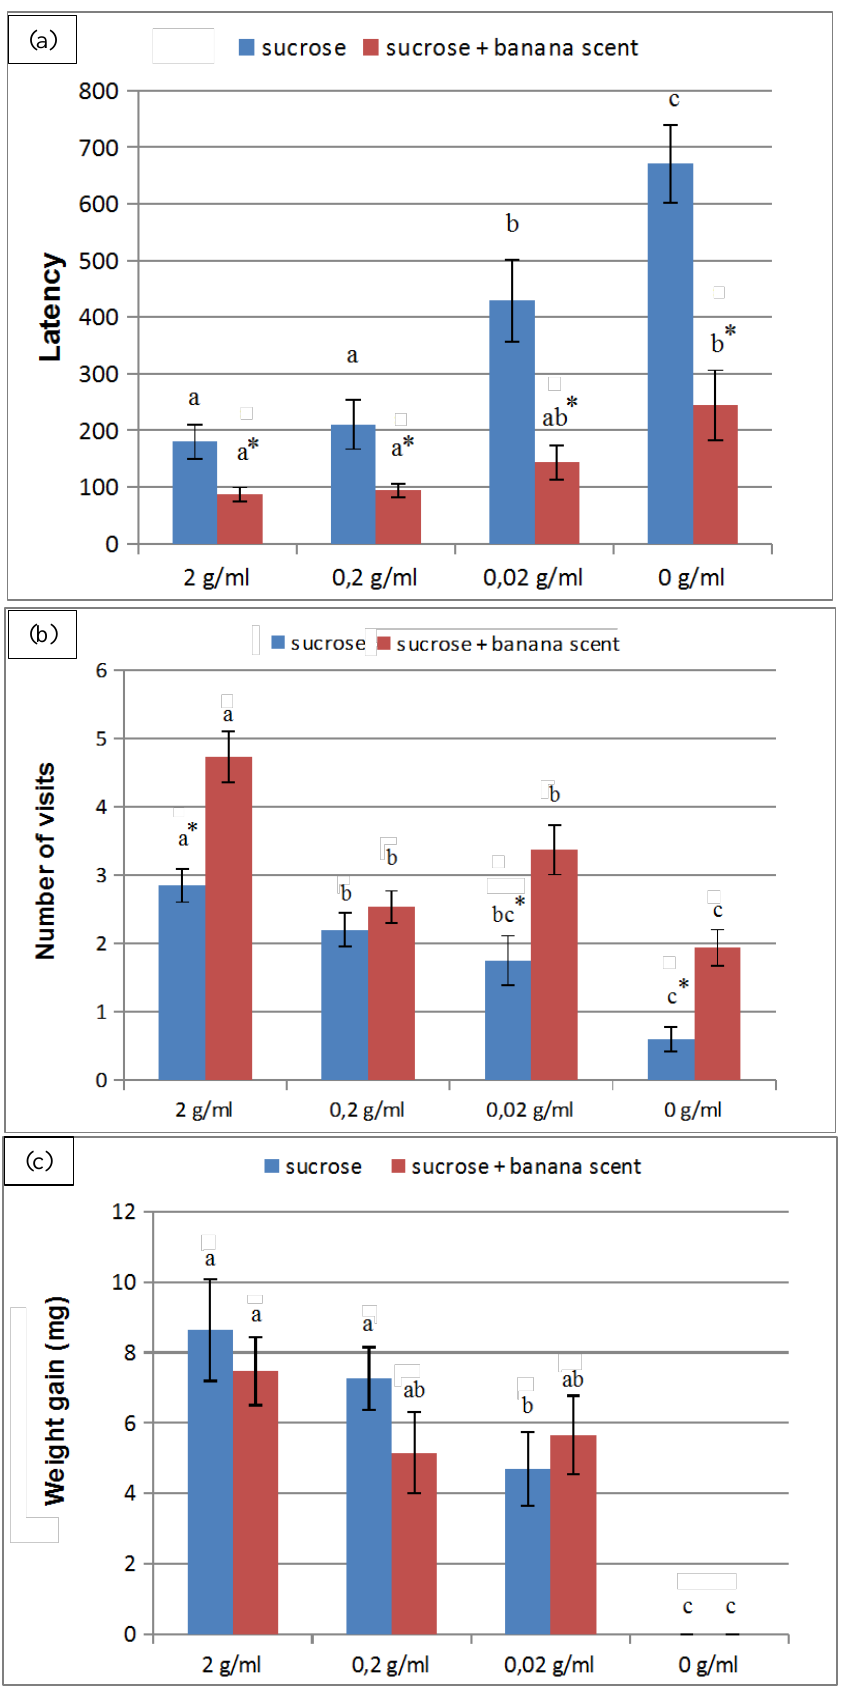
Figure 2. Feeding performance of B. germanica with sucrose solutions in distilled water. The following parameters were analyzed: a) Latency; b) Number of visits to the source; c) Weight gain. Different letters indicate statistically significant differences among treatments; marks indicate statistically significant differences between